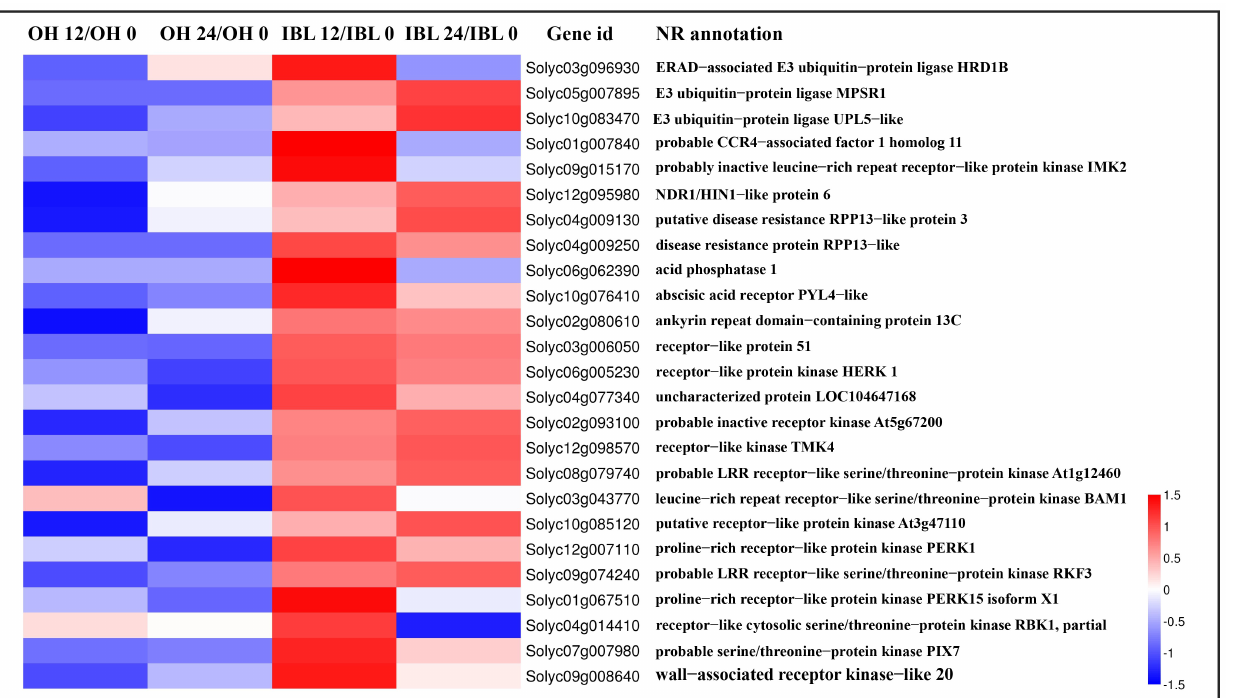
Figure 4. Heat maps exhibiting the expression profiles of potentially resistance-related genes. Data were the Log2 value of gene expression fold changes and were normalized based on Z-score formula. The blue color means the value was lower than the mean of 4 Log2 values from two lines at two time-points, and not the down-regulation. The red color means the value was higher than the mean of 4 Log2 values from two lines at two time-points, but not up-regulation. The darker color represents the higher deviation from the average. OH 12/OH 0 and OH 24/OH 0 represent the ratio of gene expression value at 12 hpi and 24 hpi compared to value at 0 hpi in Ohio88119, respectively; IBL 12/IBL 0 and IBL 24/IBL 0 represent the ratio of gene expression value at 12 hpi and 24 hpi compared to value at 0 hpi in IBL2353,